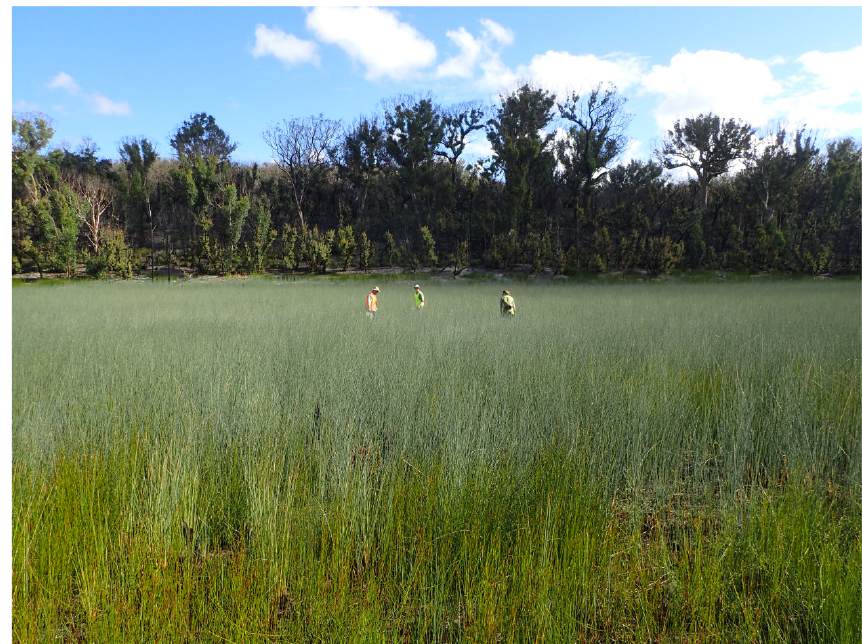
Figure A1. North Stradbroke Island wetland with typical vegetation of eucalypt species on the surrounding dunes.